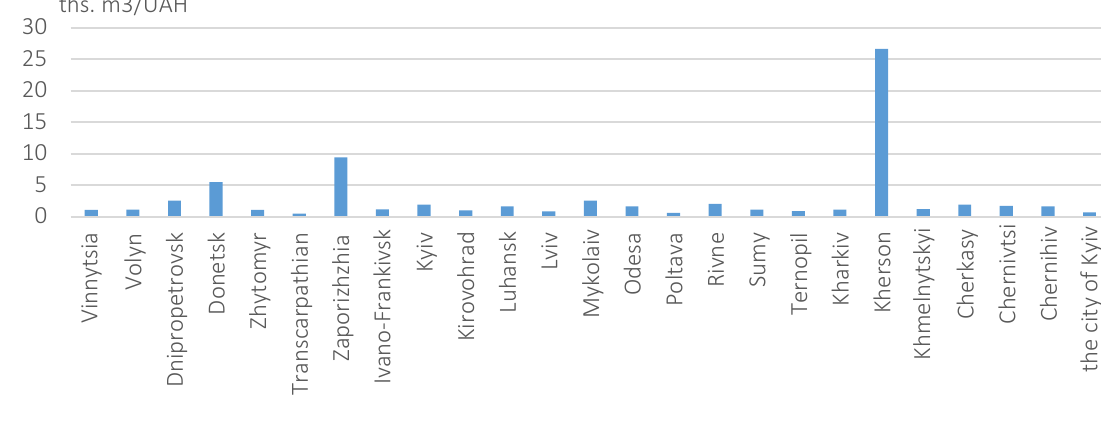
Figure 3. Water capacity of GRP in 2017, ths. m 3 per 1